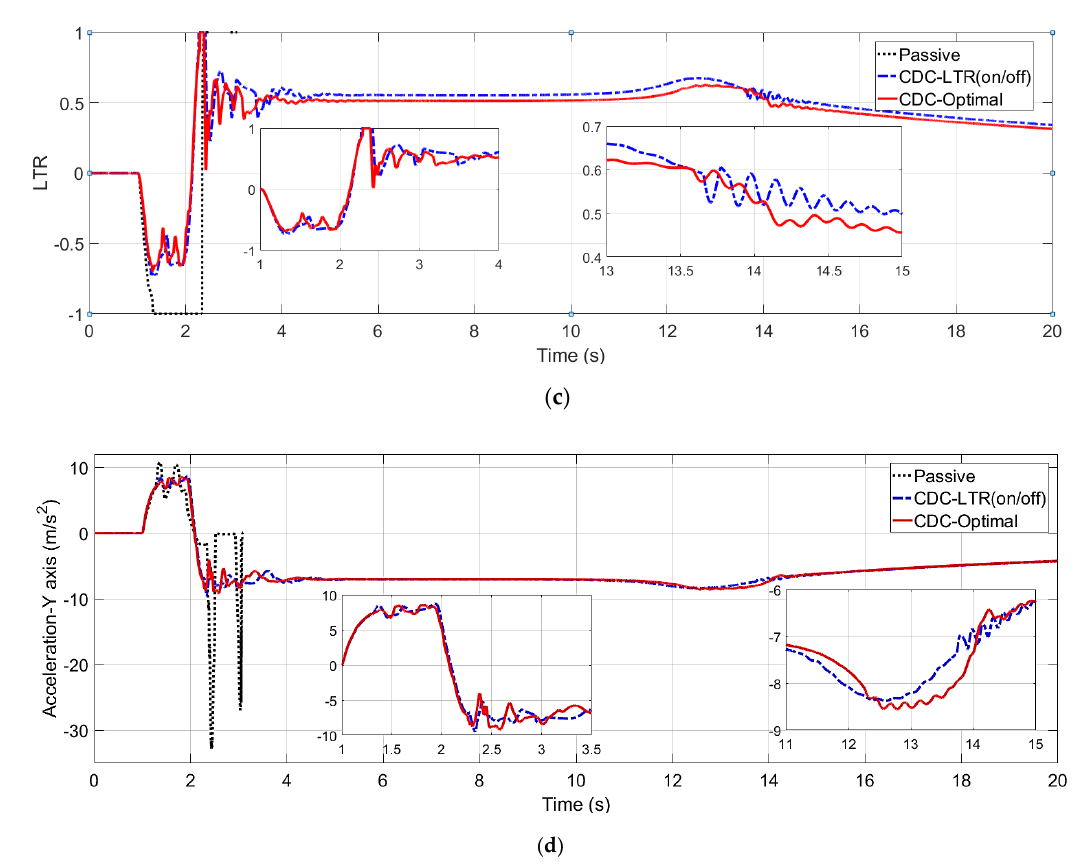
Figure 7. Roll angle, roll angle rate, LTR, and lateral acceleration of fishhook test. The result of passive suspension is expressed by the black dotted line. The result of CDC-LTR is expressed by the blue chained line. The result of CDC- optimal distribution damping force (ODDF) is expressed by the red solid line. ( a ) is the comparison result of the roll angle. ( b ) is the comparison result of the roll angle rate. ( c ) is the comparison result of LTR. ( d ) is the comparison result of lateral acceleration. To observe the comparison of the two CDC control strategies more conveniently, a local view in which passive suspension is removed is added.